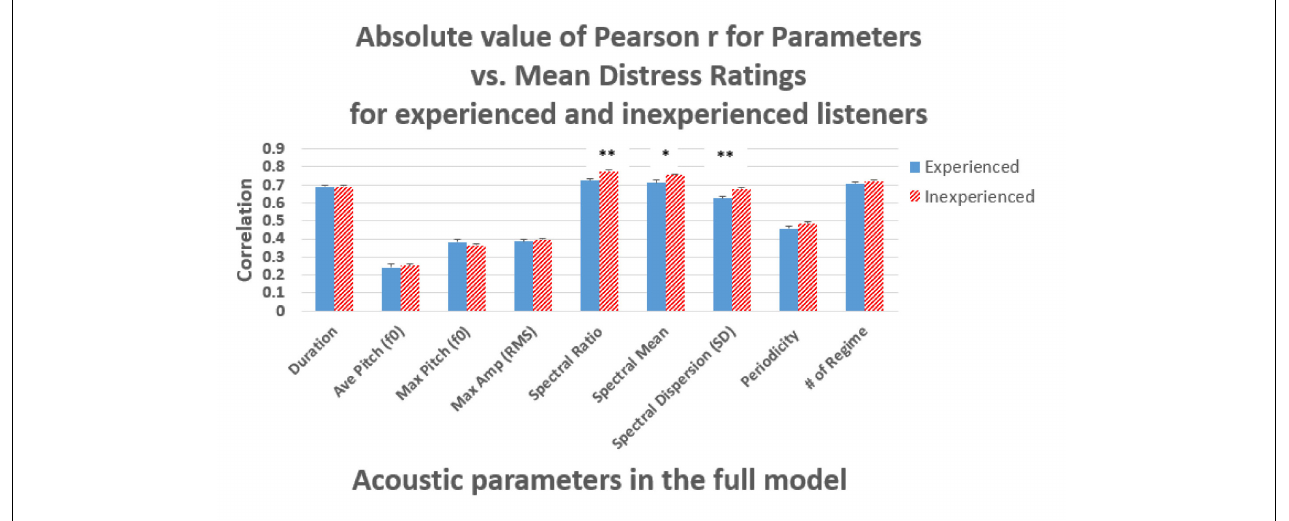
FIGURE 3 | Pearson correlations between each of nine acoustic parameters and the mean ratings of distress level by experienced and inexperienced listeners. Spectral Ratio, Spectral Mean, and Spectral Dispersion (SD) were significantly different across groups (see Appendix 4 to view statistics on all 9 parameters). Error bars = ± 1 SEM. ∗ p < 0.05, ∗∗ p <